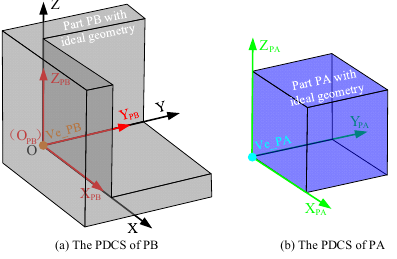
Figure 9. Established part definition coordinate systems (PDCSs) and view coordinate system.